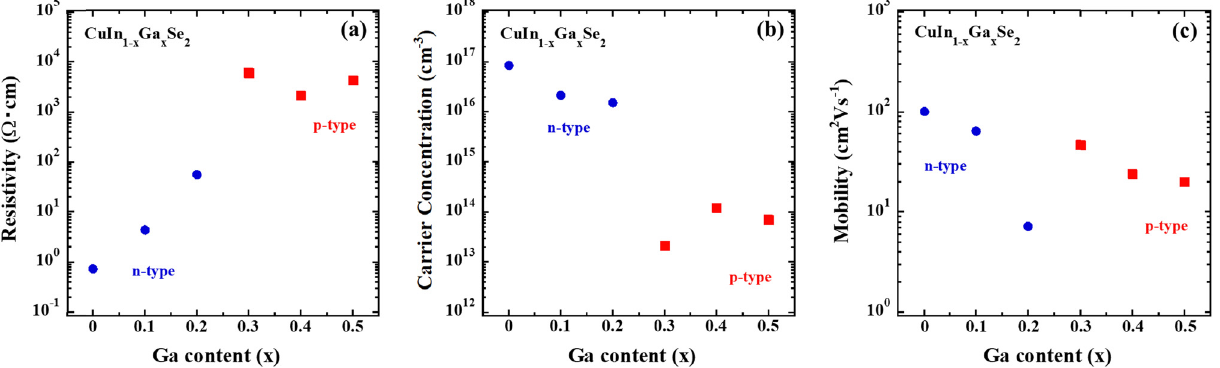
Figure 5: Electrical properties of ( a ) resistivity, ( b ) carrier concentration, and ( c ) mobility by Hall e ff ect measurement. Circle and square symbols represent n - type and p - type, respectively.